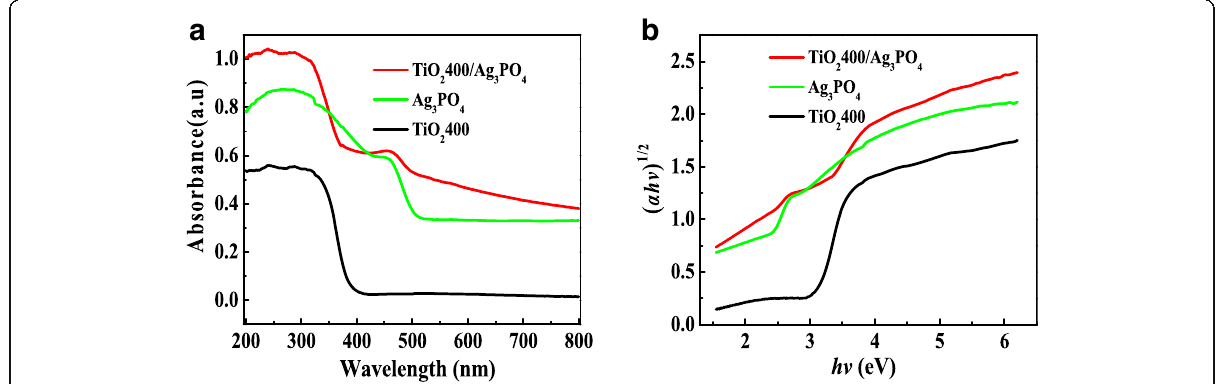
Fig. 4 TiO 2 400, Ag 3 PO 4 , and TiO 2 400/Ag 3 PO 4 catalysts: a UV-Vis DRS, b plots of ( α hv) 1/2 versus energy